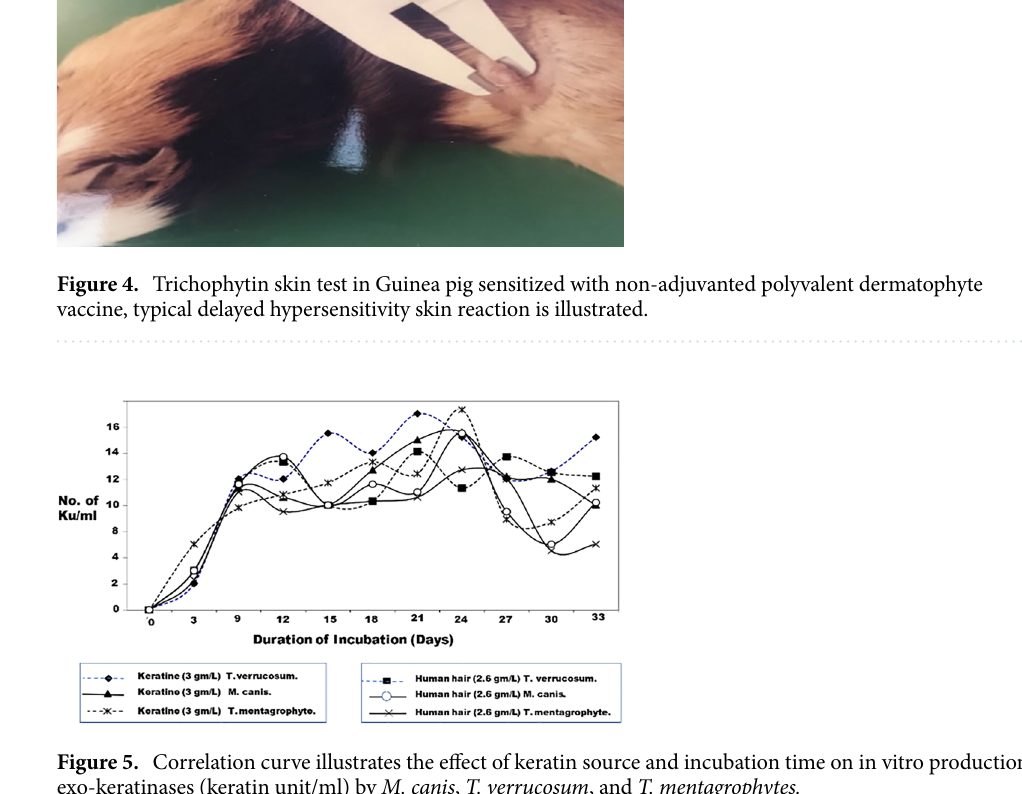
Immunological activities of dermatophyte exo‑keratinases.